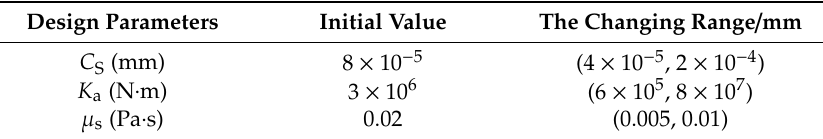
Figure 5. Schematic diagram of the variable-structured SFD. Table 1. SFD Scheme structure variable.